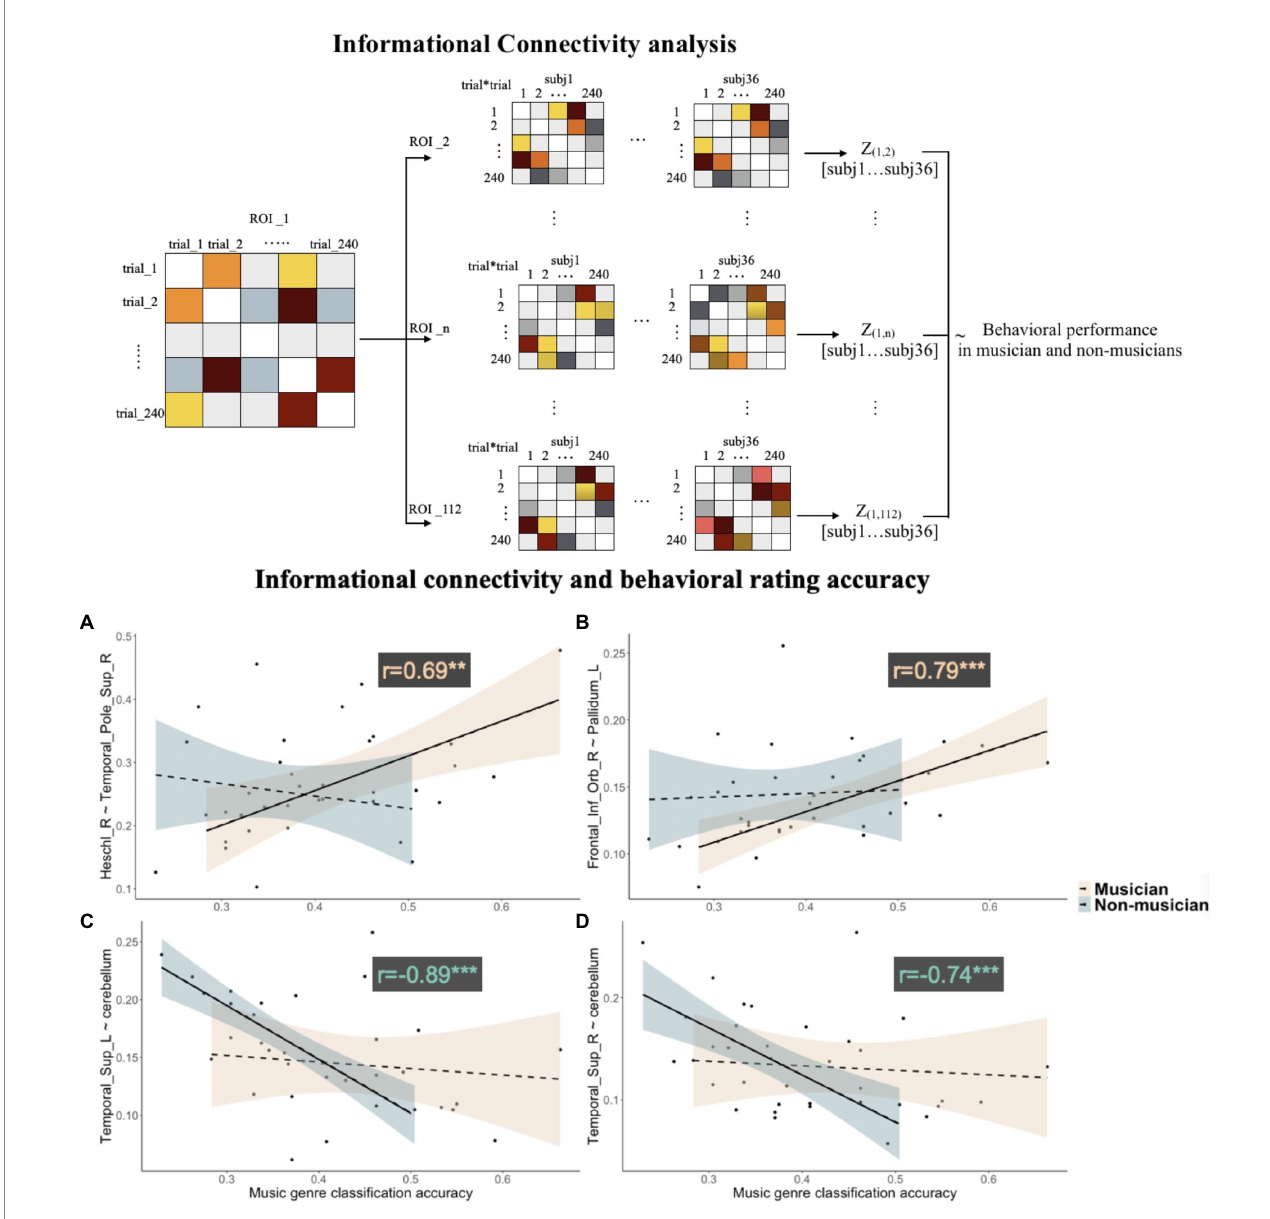
FIGURE 4 Upper panel: illustration for computing informational connectivities between ROIs for all the participants. Lower panel: correlations between informational connectivities and behavioral classification accuracy in musicians and non-musicians, for (A) connectivity between right Heschl’s gyrus and right superior temporal pole, (B) connectivity between right IFG pars orbitalis and left pallidum, (C) connectivity between the left superior temporal gyrus and cerebellum, and (D) connectivity between right superior temporal gyrus and